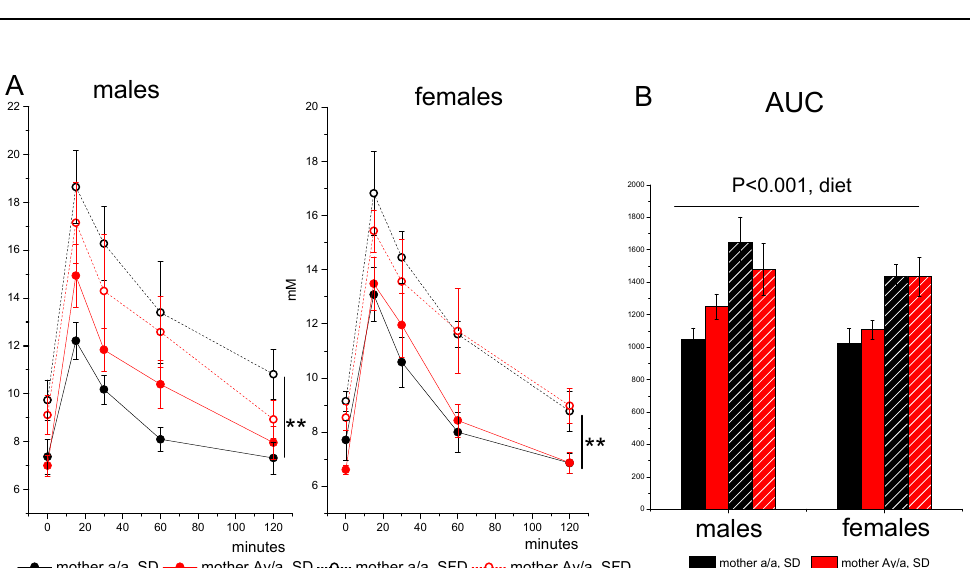
Figure 4. Blood glucose concentrations ( A ) and areas under curves ( B ) during i.p. glucose tolerance test in male and female offspring of control ( a/a ) and obese ( A y /a ) mothers. Male and female offspring were fed with SD or SFD during 10 weeks from the age of 10 weeks. Data are presented as mean ± SE. The number of animals in groups is shown in Table 2. Data were analyzed by repeated measures ANOVA with factors “sex”, “diet”, and “MG” for five repeated measures of glucose in blood, and by three-way ANOVA with factors “sex”, ‘diet”, and “MG” for AUC: ** p < 0.01, diet, repeated measures ANOVA.